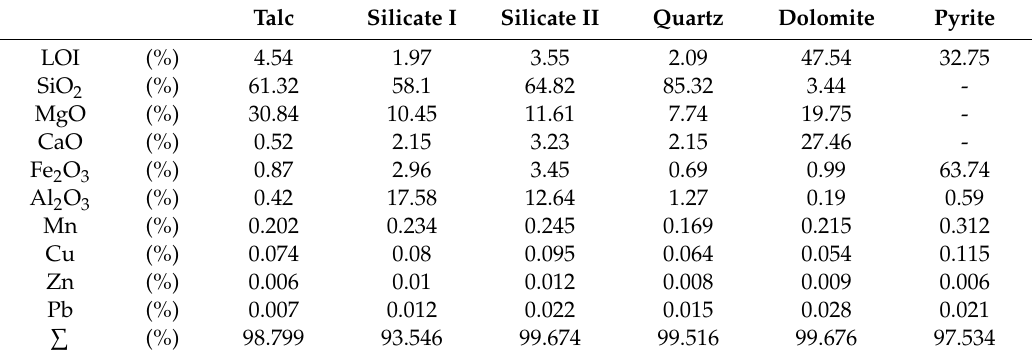
Table 1. Chemical analysis of minerals identified in the sample of the ore. Note: Loss on ignition (LOI) at 1000 ◦ C.